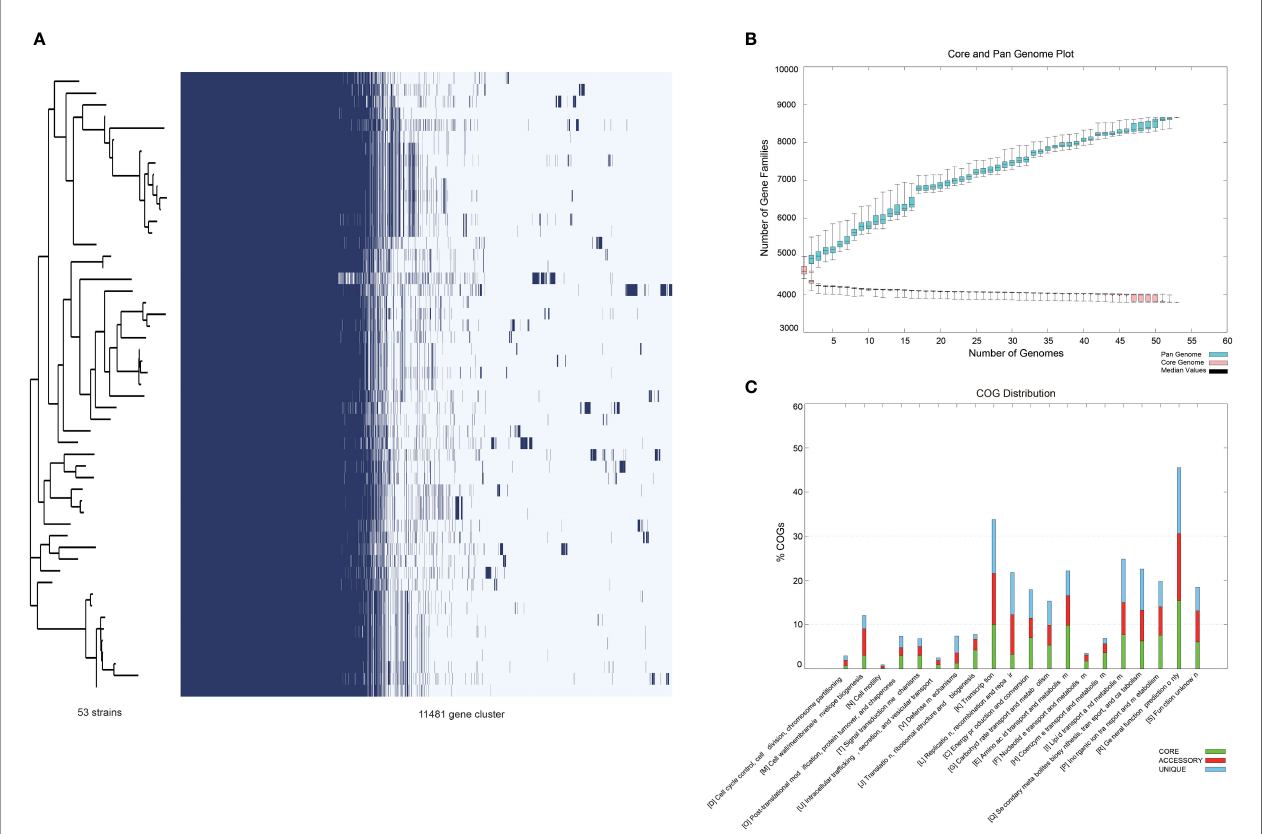
FIGURE 3 | Pan-genomic analysis of 53 R. equi strains. (A) Pan-genomic distribution. The tree on the left represented the evolutionary relationship based on Pan- genome, while the fi gure on the lift represented the presence and absence of core and accessory genes. (B) Number of gene family. (C) The COG distribution. Green color represented core gene, red and blue represented accessory gene and unique gene,